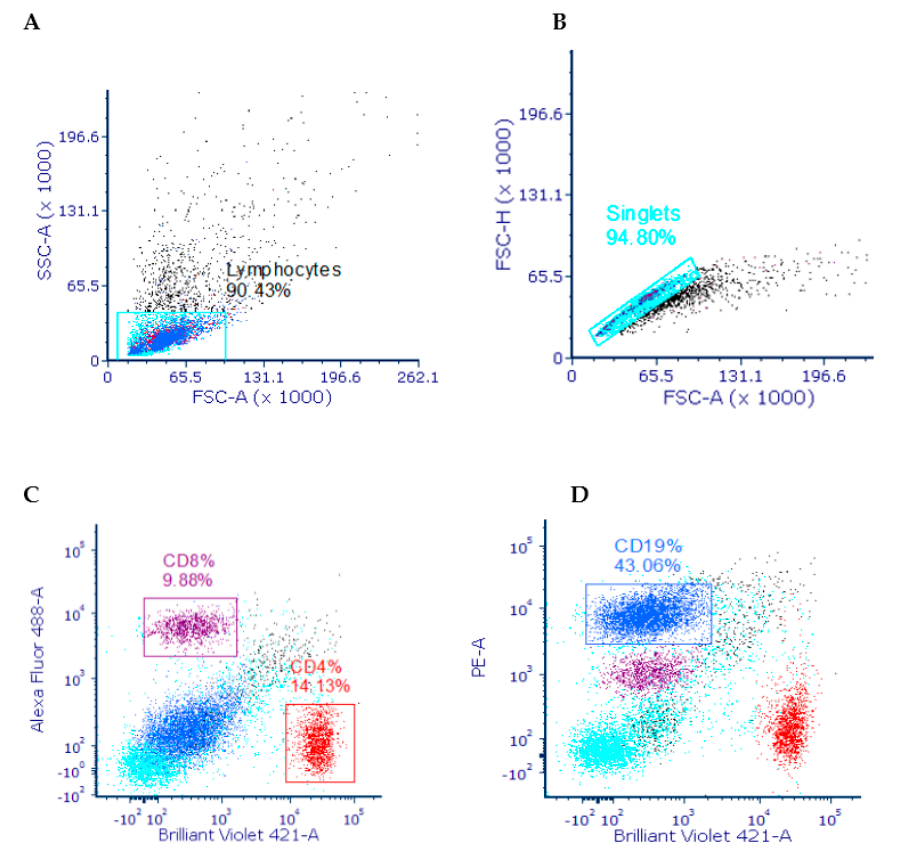
Figure 7. After gating the singlet cell population on FSC-H vs FSC-A axes, to discriminate against the doublets, CD4% gated in red, CD8% gated in maroon and CD19% gated in blue. Over 95% of the cell population remained viable at point of analysis. ( A ) gating for lymphocytes ( B ) separating the singlets from doublets ( C ) gating CD4 and CD8 marker = T lymphocyte percentages ( D ) gating for CD19 marker = B lymphocyte percentage.